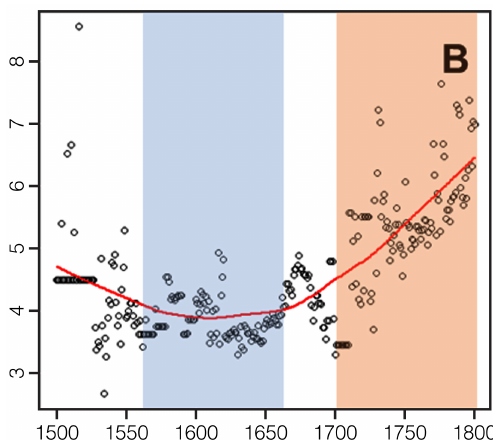
Figure 3. Average crop yield ratio in Eastern and Western Europe. ( A ) Average crop yield ratio in Eastern Europe; ( B ) average crop yield ratio in Western Europe. Note: Scatter plots in the figure are the raw data of crop yield ratio. Red line represents the general trend of crop yield ratio that is derived from non-parametric analysis. Blue shade indicates the extreme cooling period during the Little Ice Age (AD 1560–1660), while red shade indicates the warm agricultural recovery period (AD 1700– 1800).